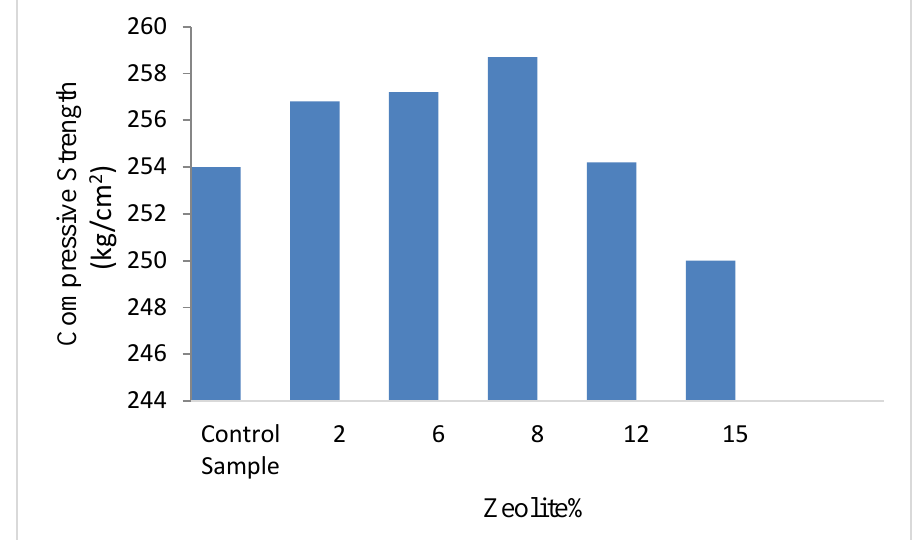
Fig. 4. Concrete strength with different percentages of Zeolite with 400 grade cement at 28 days old